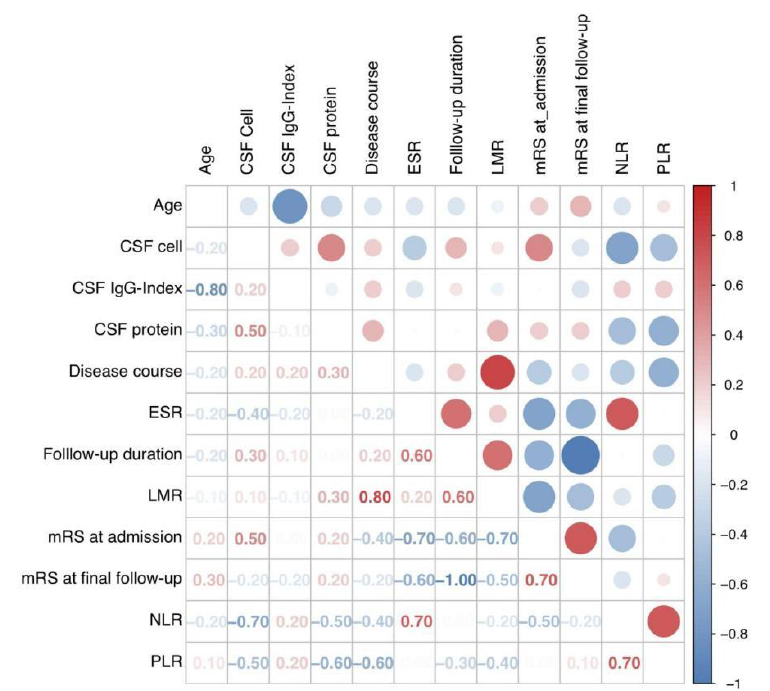
Figure 3. Correlation matrix plot showing Pearson’s correlation coefficient between each variable. Abbreviations: CSF, cerebrospinal fluid; ESR, erythrocyte sedimentation rate; LMR, lymphocyte-to- monocyte ratio; mRS, modified Rankin Scale; NLR, neutrophil-to-lymphocyte ratio; PLR, platelet-to- lymphocyte ratio.